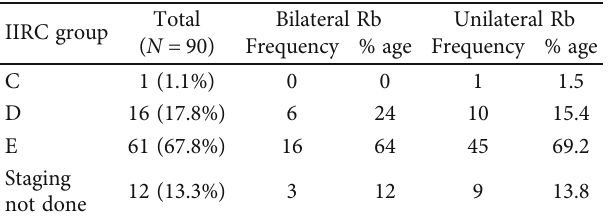
Table 2: IIRC classi fi cation of children with retinoblastoma at UCI based on worst a ff ected eye(s).